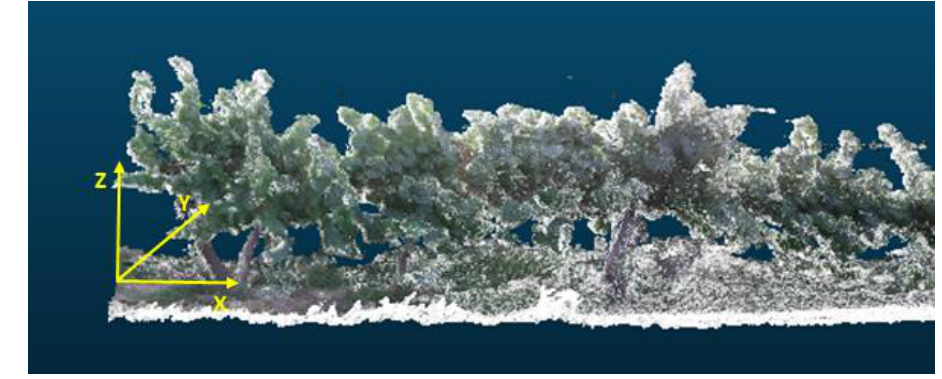
Figure 7. The coordinate system defined in yellow.